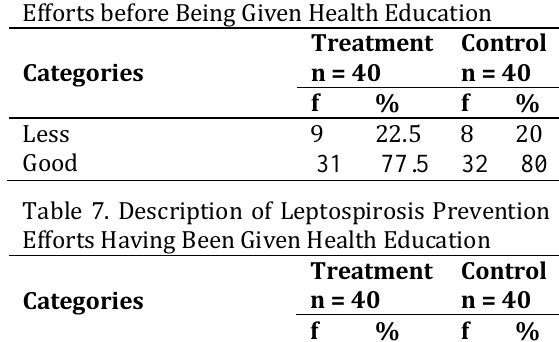
Table 6. Description of Leptospirosis Prevention